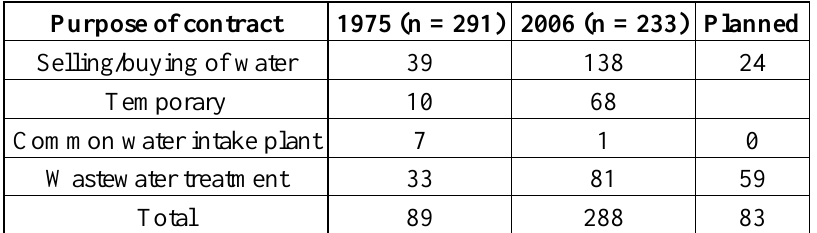
Table 1. Number of bilateral contracts in 1975 and 2006 and planned ones [4]. Purpose of contract